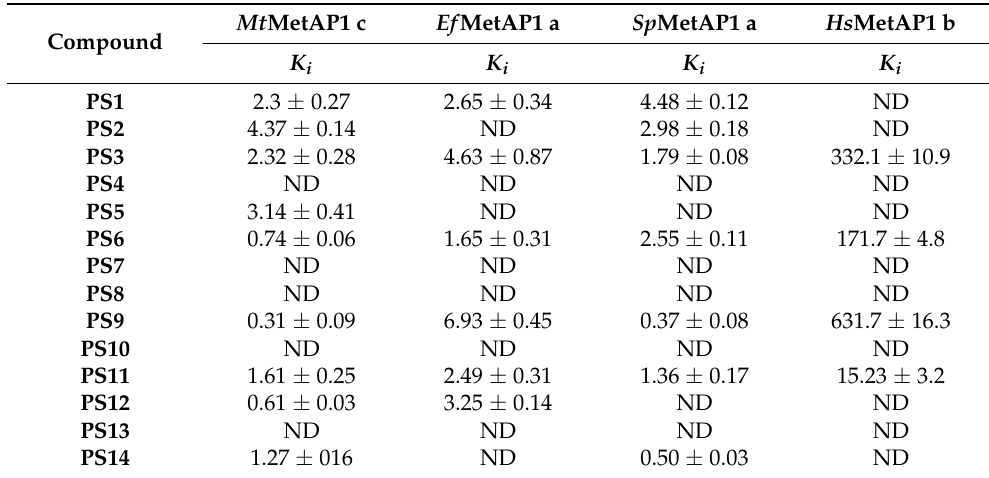
Table 1. K i (in µ M) calculation using the Morrison K i method against four different methionine aminopeptidases.